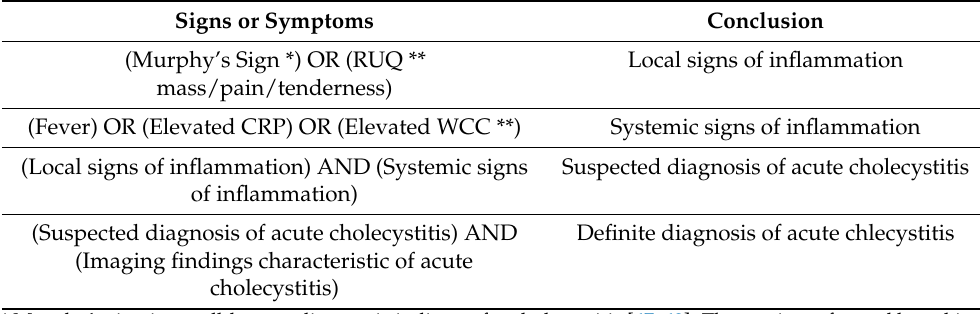
Table 2. Tokyo Guidelines for diagnosis of acute cholecystitis, once acute hepatitis, other acute abdominal diseases and chronic cholecystitis have been excluded.